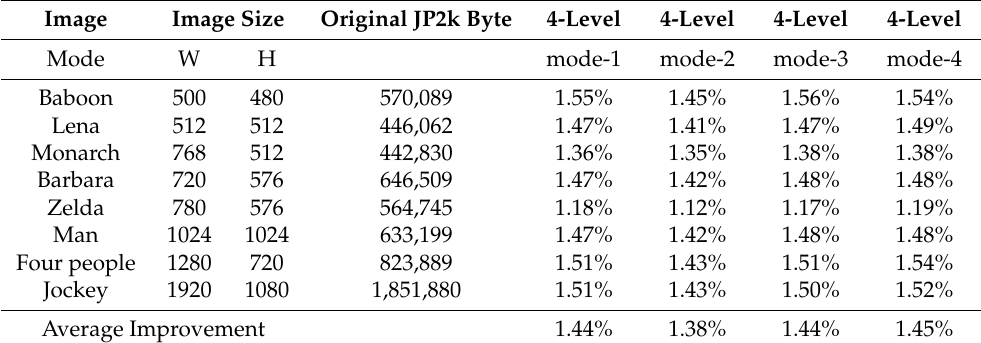
Table 18. Improvement percentage of compressed byte with proposed algorithm applying